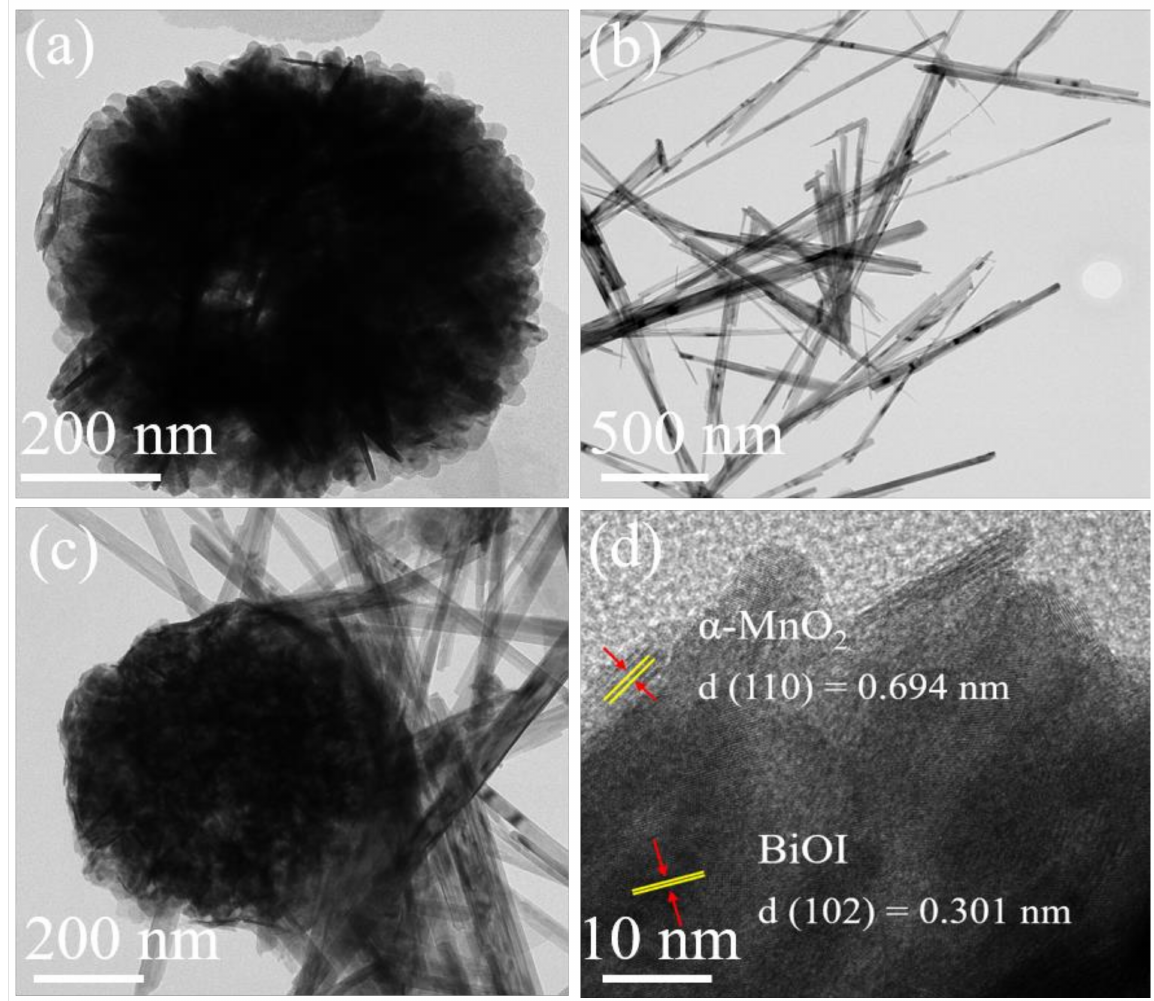
Figure 2. TEM images of as-prepared samples: ( a ) pure BiOI; ( b ) pure α -MnO 2 ; and ( c , d ) TEM and HRTEM images of MBI2